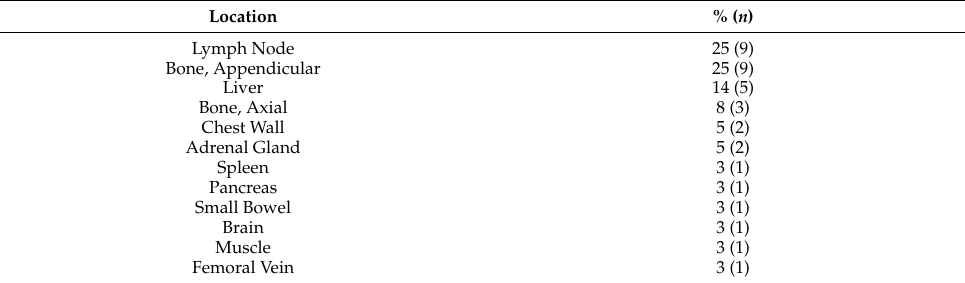
Table 4. Locations of extrapulmonary